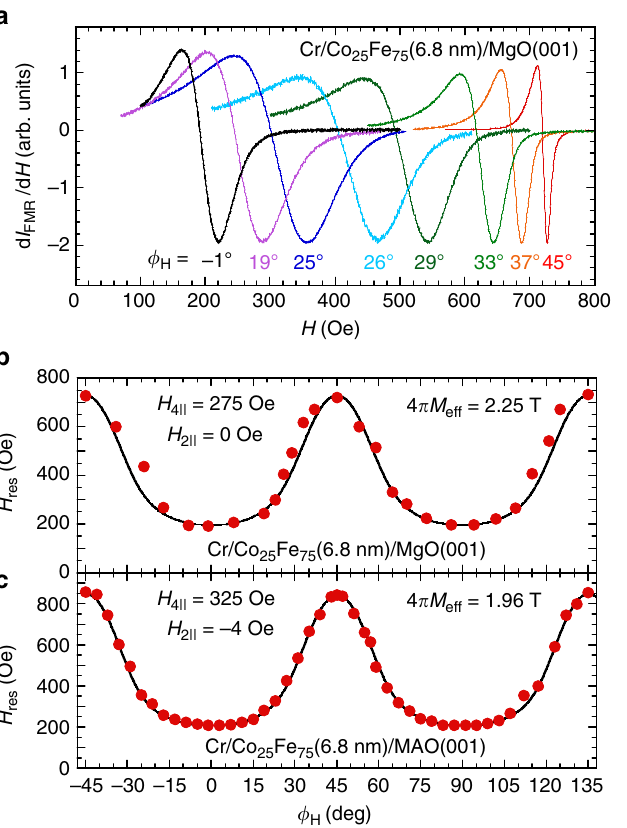
Fig. 4 Angular dependence of ferromagnetic resonance. a Derivative ferromagnetic resonance (FMR) absorption spectra for a Cr(2.8 nm)/ Co 25 Fe 75 (6.8 nm)/MgO(001) sample at in-plane angles ϕ H from − 1° to 45°. b The resonance fi elds of the FMR spectra in a plotted against ϕ H . From the fi t to the experimental data the values for H 4 || , H 2 || , and 4 π M eff are extracted. c A similar H res vs. ϕ H plot for a Cr(2.8 nm)/Co 25 Fe 75 (6.8 nm)/